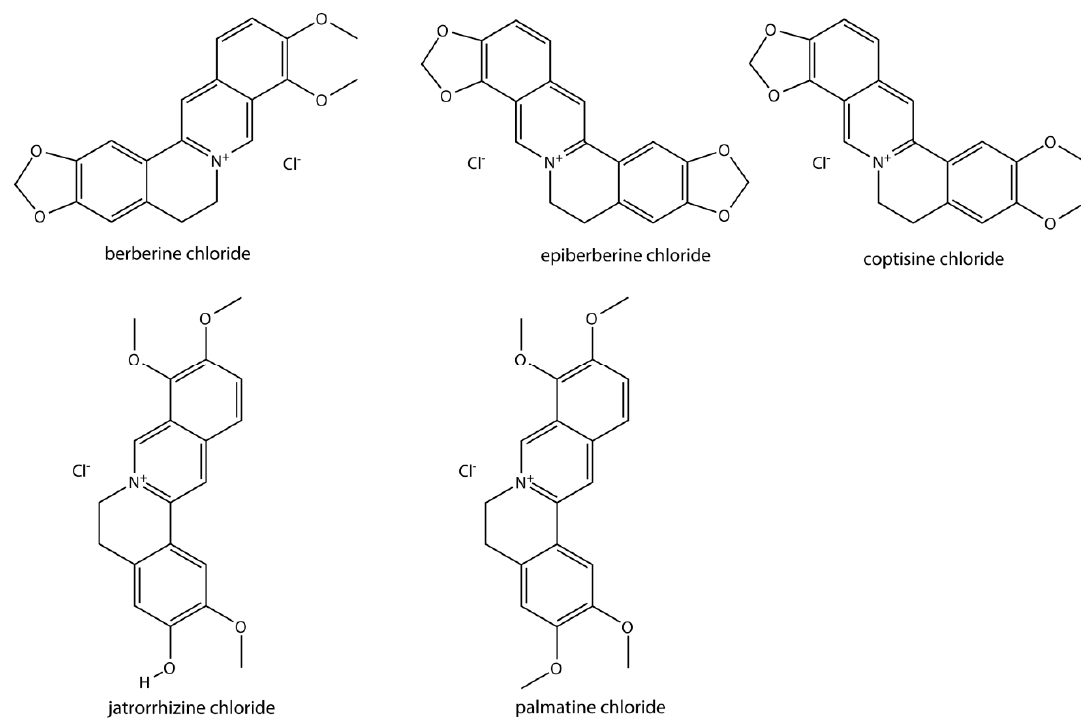
Figure 1. Structures of the five alkaloids.